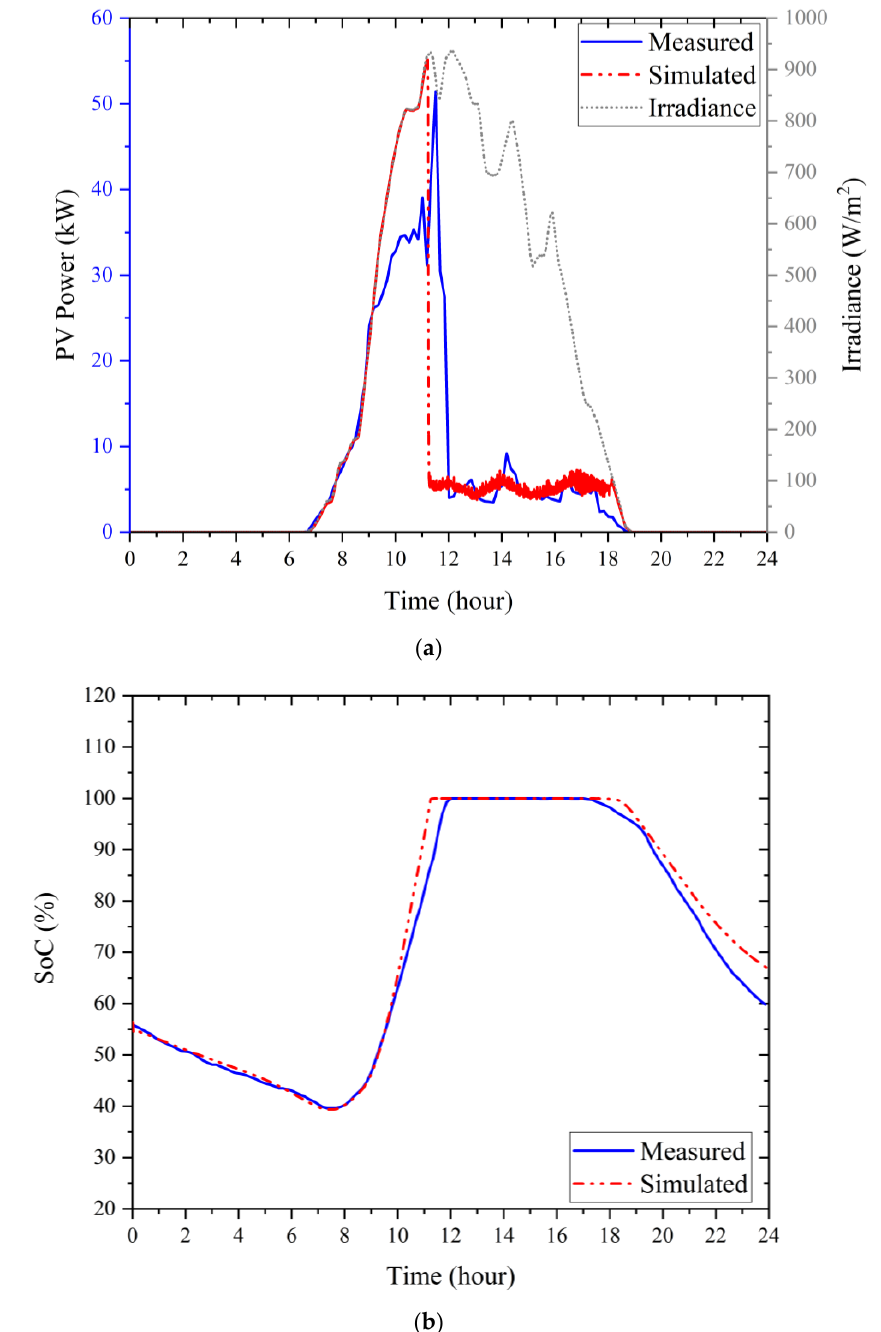
Figure 23. Validation results of PV and the battery storage system: ( a ) PV output power; ( b ) bat- tery SoC% (combined clear sky and cloudy sky day).